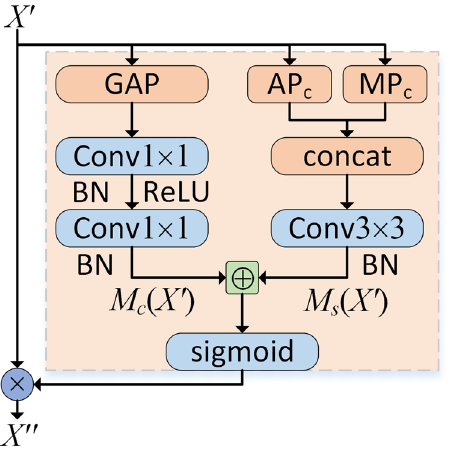
Figure 3: Channel - spatial attention